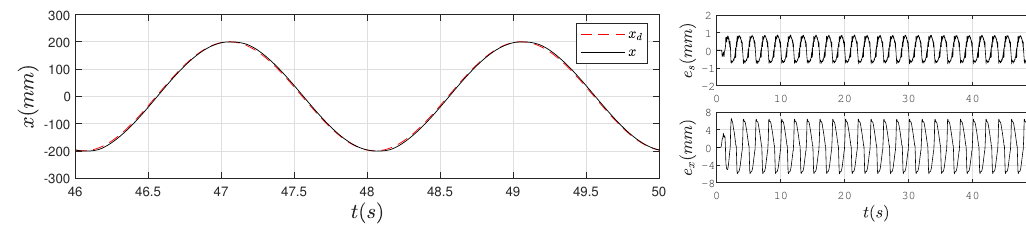
Figure 5. System output under the PD controller and low-frequency excitation.